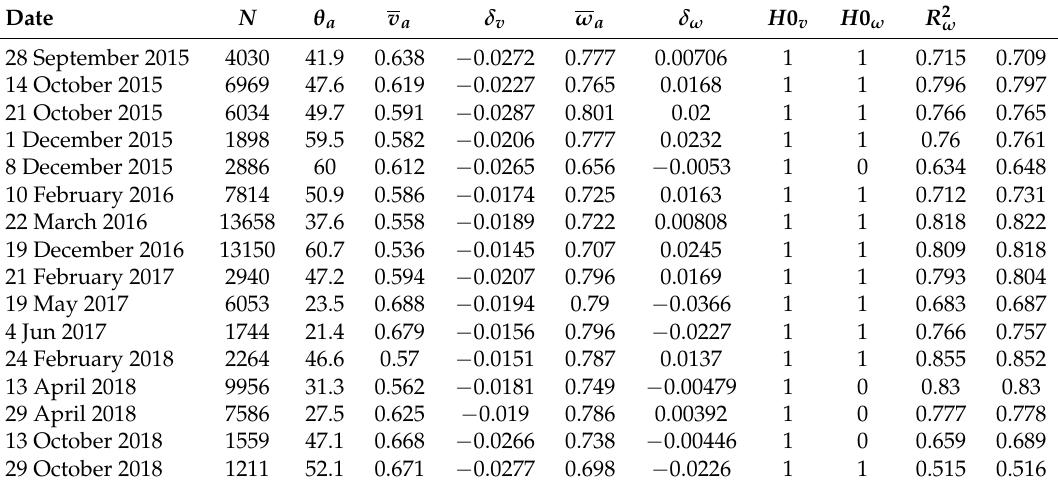
Table 7. Summary of the statistical analyses showing agreement between the AHI and MODIS NDVIs as well as between the AHI and MODIS NDVI-based indices over the Shikoku region. N is the number of pixels sampled on each date. θ a is the AHI solar zenith angle averaged over the area for each date.